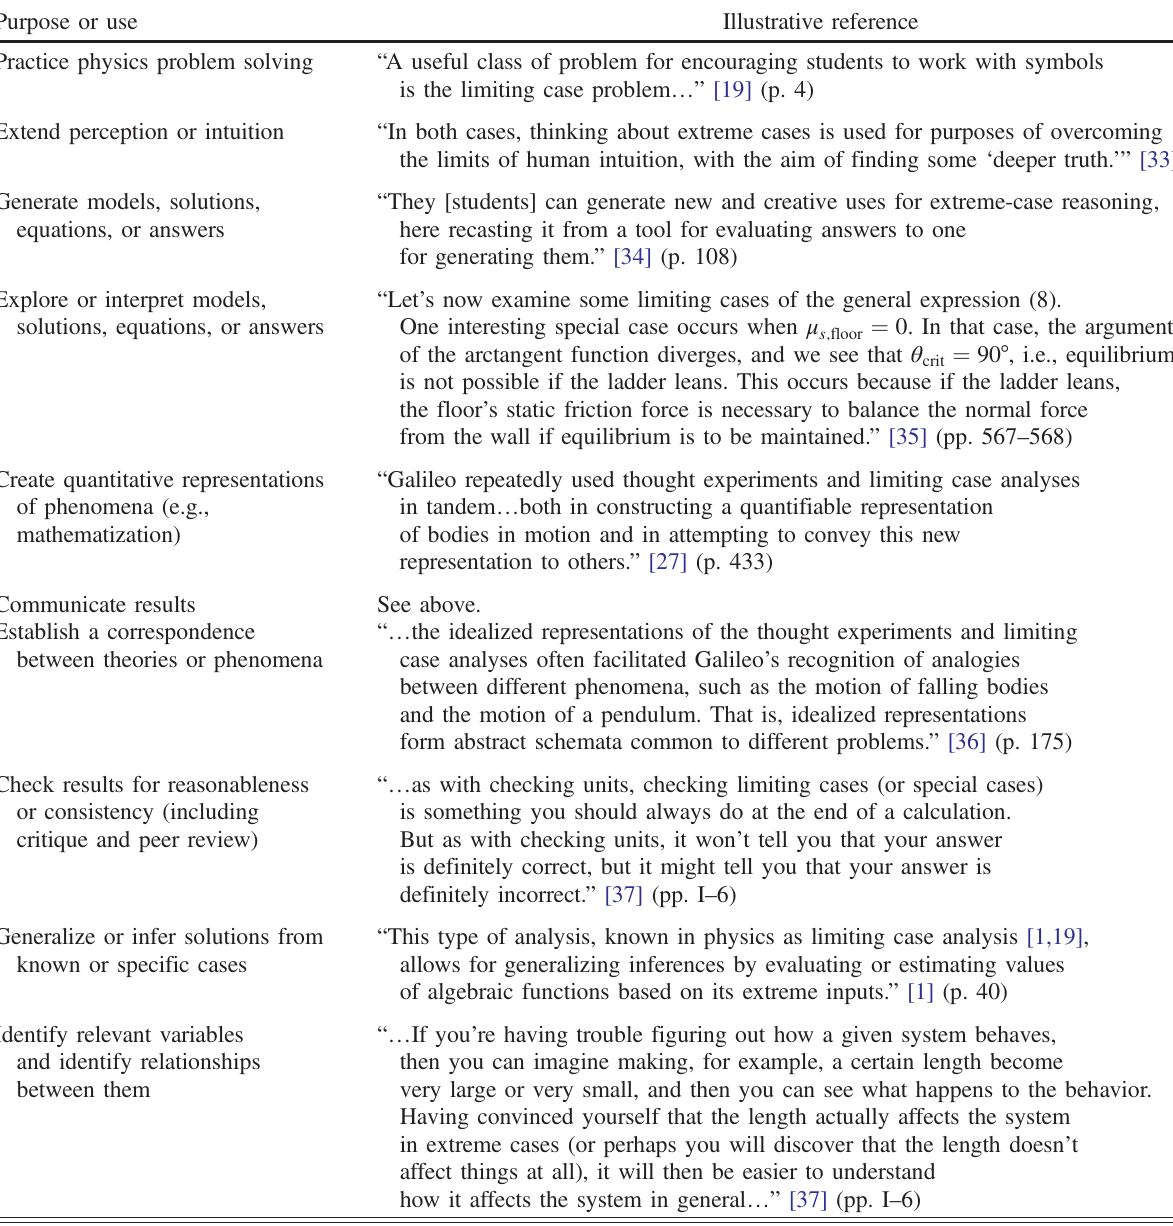
TABLE II. Some purposes and uses of limiting case analysis. Purpose or use Illustrative